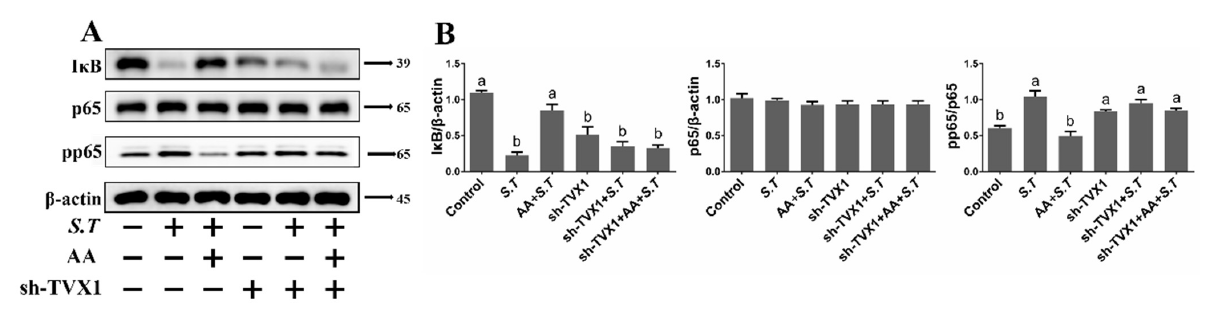
Figure 6. Effect of sh-TVX1 on AA Activation of the NF- κ B Pathway in S.T -infected Microglia. Western blotting detection of NF- κ B pathway protein changes in microglia. ( A ) Microglia were transfected with sh-TVX1 plasmid. Twenty-four hours later, cells were pre-treated with AA for one hour, then infected with S.T , and proteins extracted for analysis. ( B ) NF- κ B pathway protein grayscale images (Different letters represent significant differences, p < 0.05, n = 3).